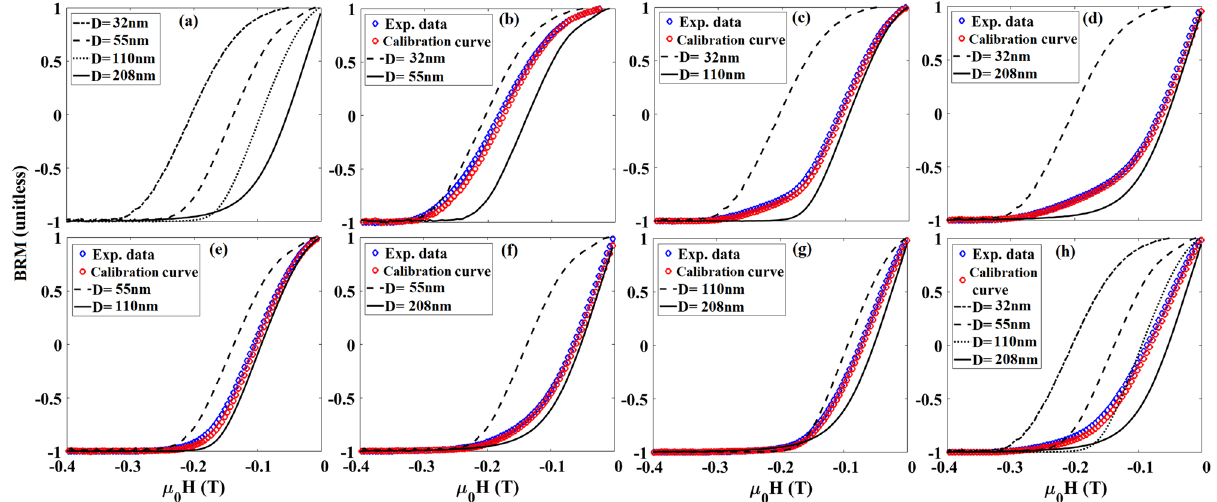
Figure 6. Normalized backfield remanence magnetization (BRM) results for ( a ) individual types of MNW, ( b – g ) different combinations of two types of MNWs, as indicated in the legend and ( h ) one combination of four types. The blue circles show measurements of combinations, and the red circles show the best match for combinations of the individual signatures (from a ) using volume ratio, see Table